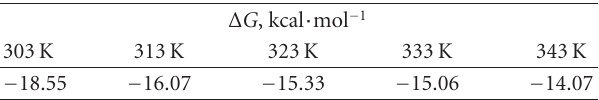
Table 6: The free energy of adsorption ( Δ G ads ) for mild steel in 1.0M HCl in the presence of 3-benzoylmethyl benzimidazolium hexafluoroantimonate (BMBI) at various temperatures (303 K– 343K).